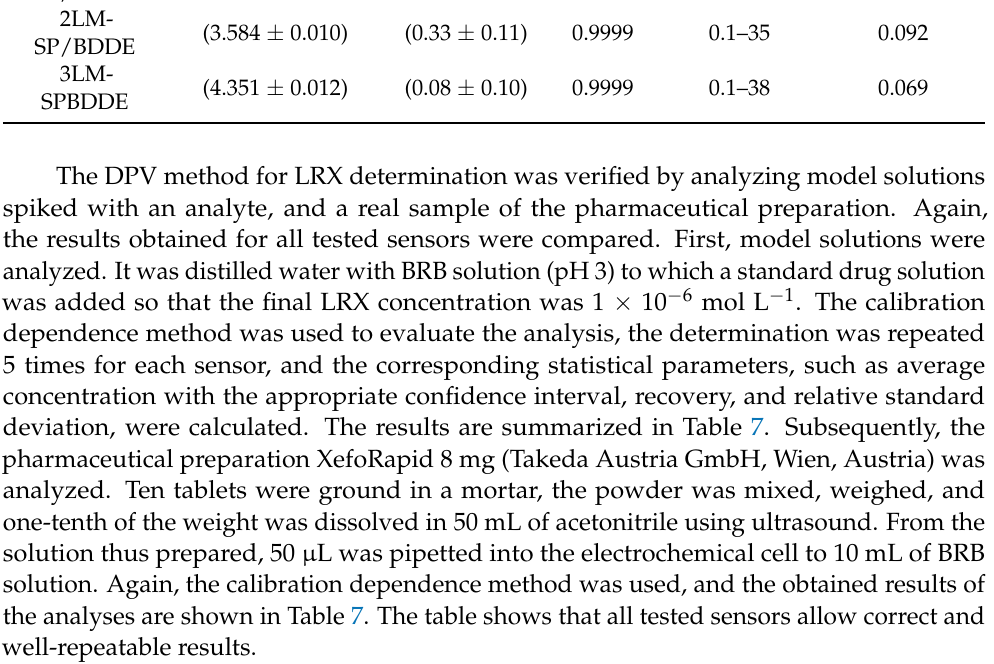
Table 7. Statistical parameters of LRX determination in model solutions and pharmaceutical